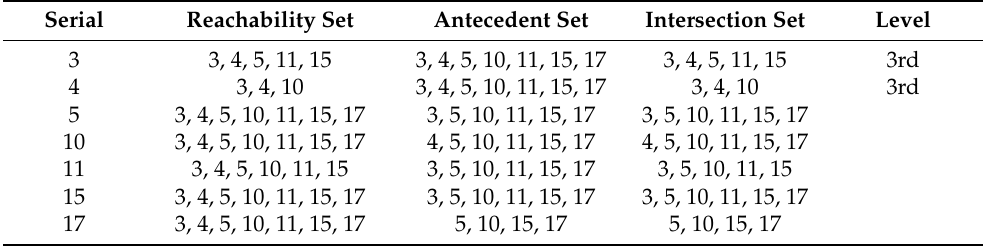
Table A3. Level partitioning (Level 3).